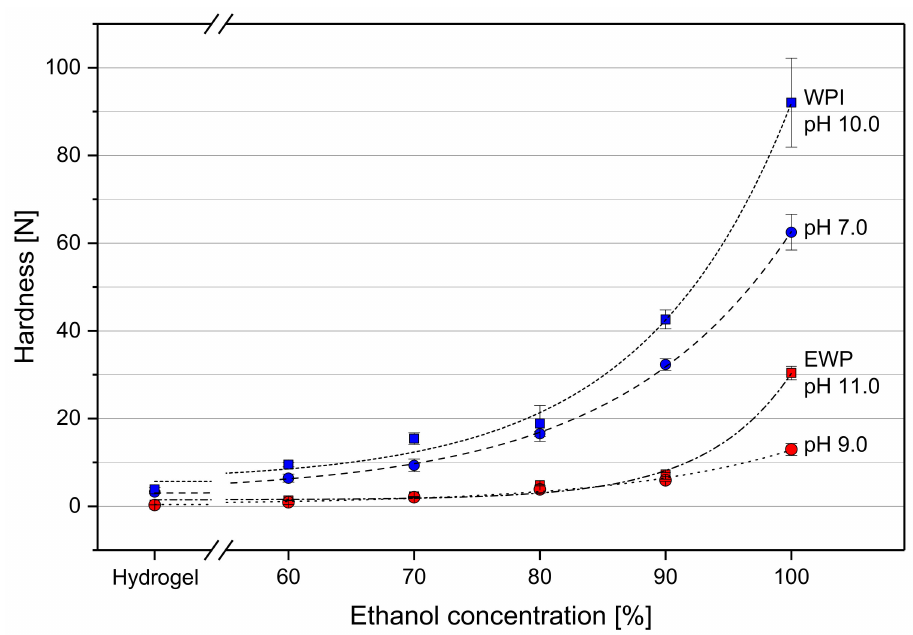
Figure 2. Hardness as the necessary force for compression of the gel spheres to 60% of their original height as a function of EtOH weight fraction in the gel after solvent exchange. WPI gel samples are marked in blue, EWP samples are in red. Circles represent the native pH, squares represent alkaline conditions. Dashed lines were added as guide to the